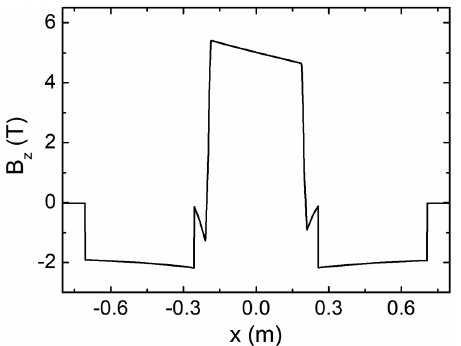
FIG. 8. Multipole field distributions along the reference path of the superconducting 90° combined-function magnet (half